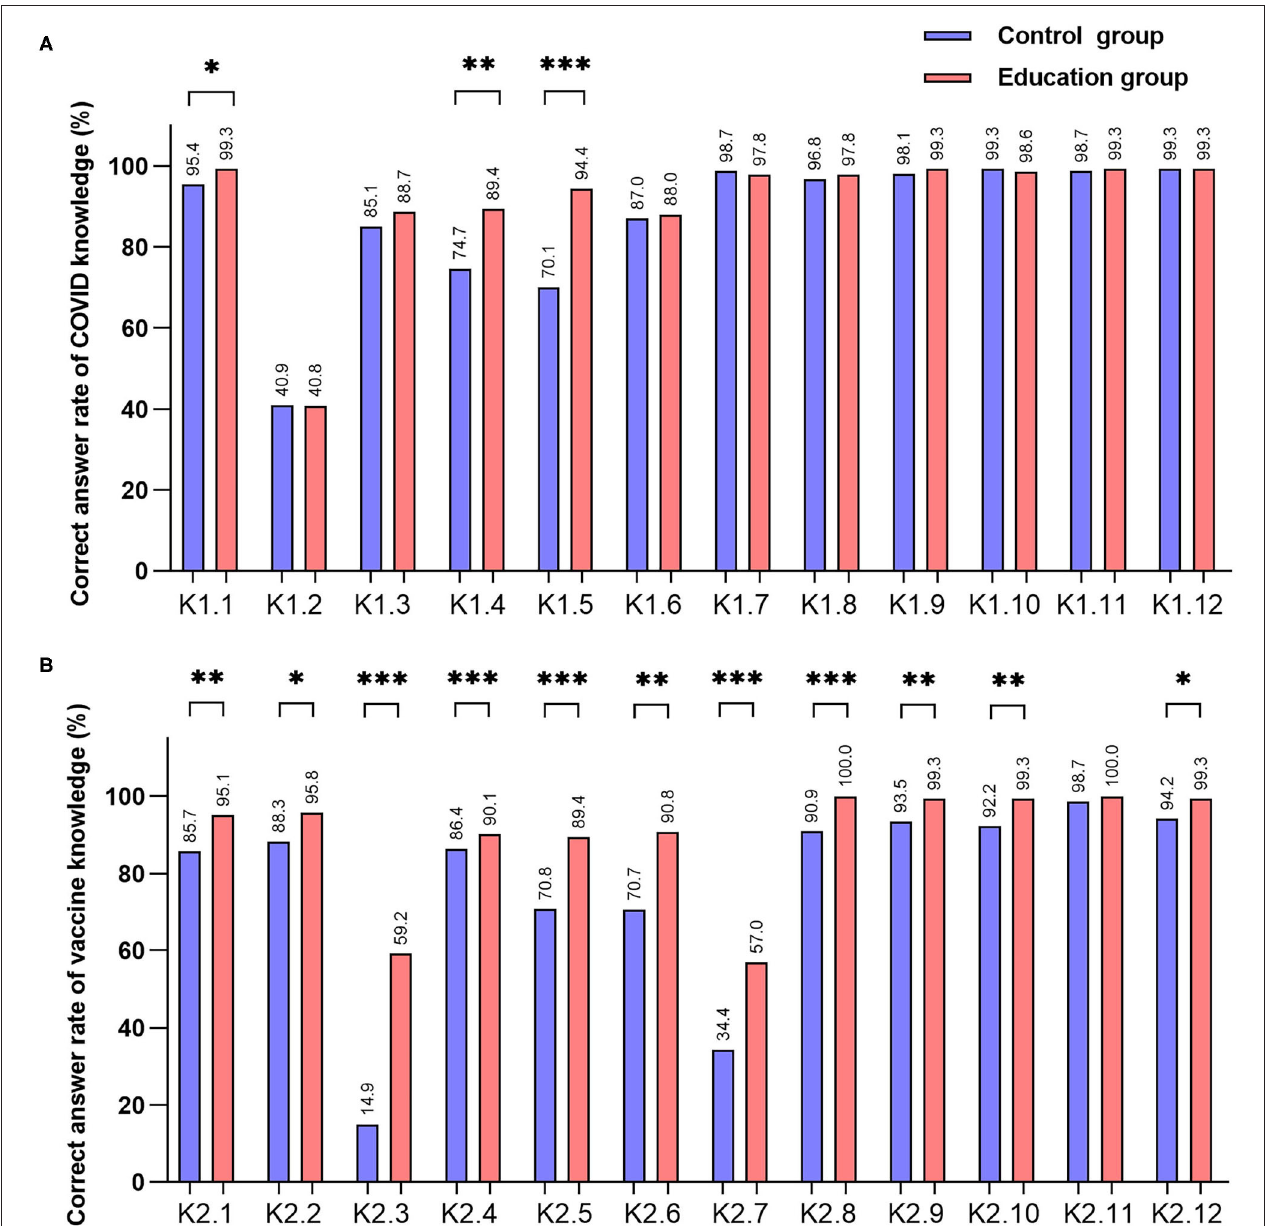
FIGURE 3 | Correct rate of knowledge by each question. [* P < 0.05, ** P < 0.01, *** P < 0.001 (A) correct answer rates of 12 questions of COVID-19 knowledge, (B) correct answer rates of 12 questions of vaccine knowledge].